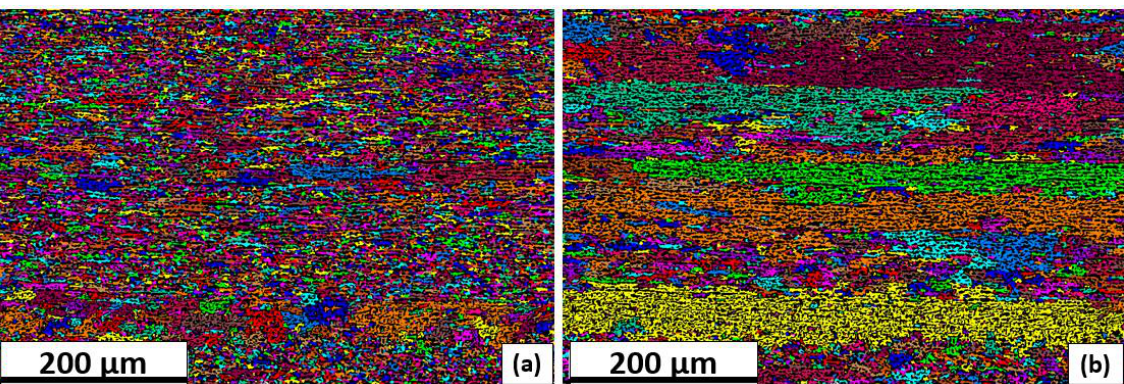
Figure 7. Ferrite grain maps with minimum misorientation of ( a ) 5° and ( b ) 15° of the ultrafine microstructure.